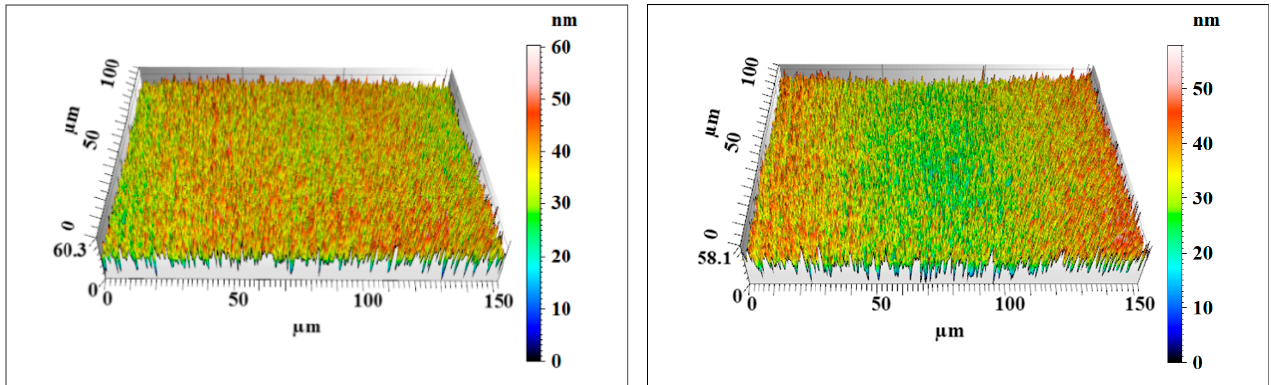
Figure 15. The nanoparticle colloid jet machining Si workpiece surface morphology.